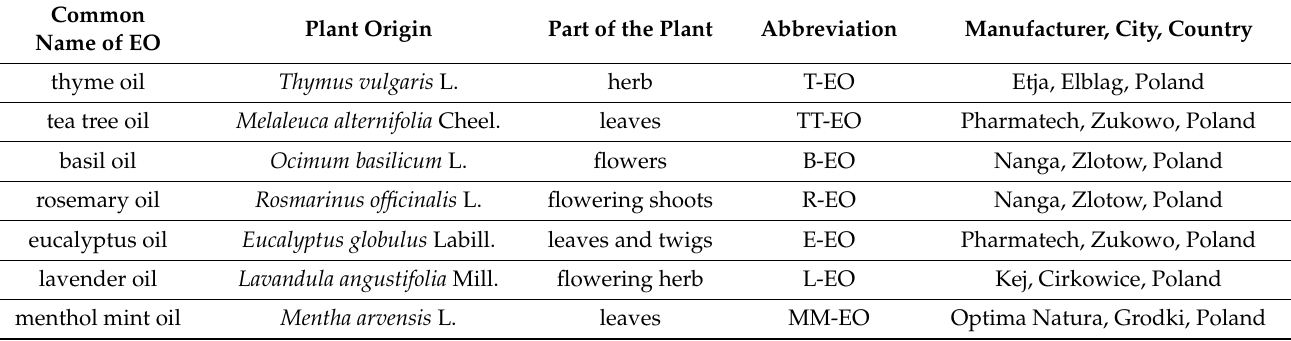
Table 8. List of the essential oils analyzed in the